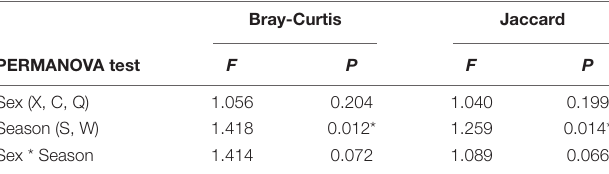
TABLE 3 | Dissimilarity tests of the microbial community composition using PERMANOVA based on Bray-Curtis and Jaccard distance. PERMANOVA, permutational multivariate analysis of